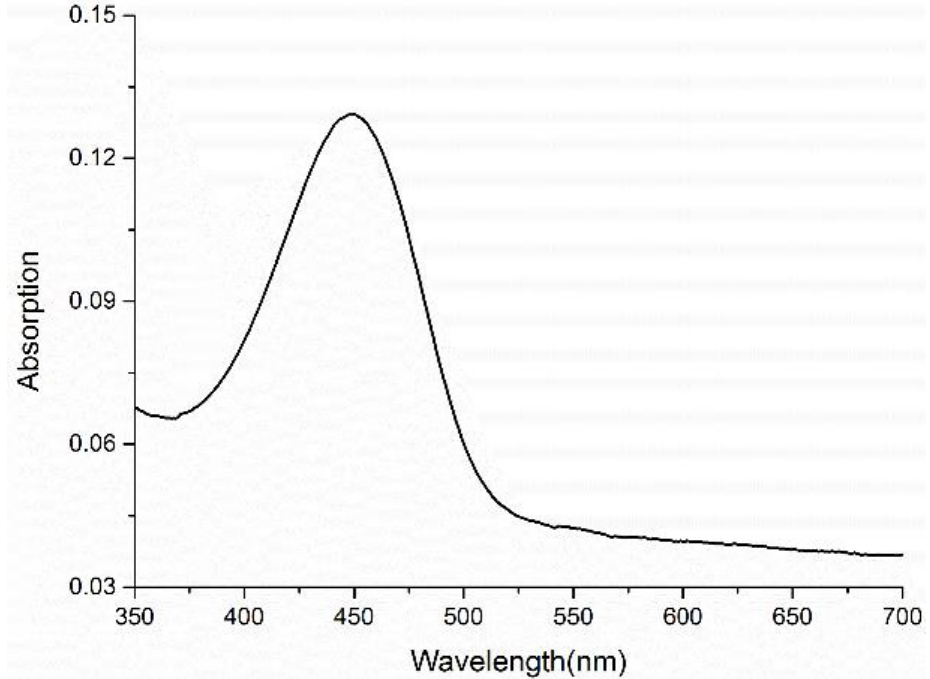
Figure 1. Absorption spectra of 100 μm Nap-I in 100 mM Tris-HCl buffer with 1% DMSO as co-solvent (V Water /V DMSO = 99:1).